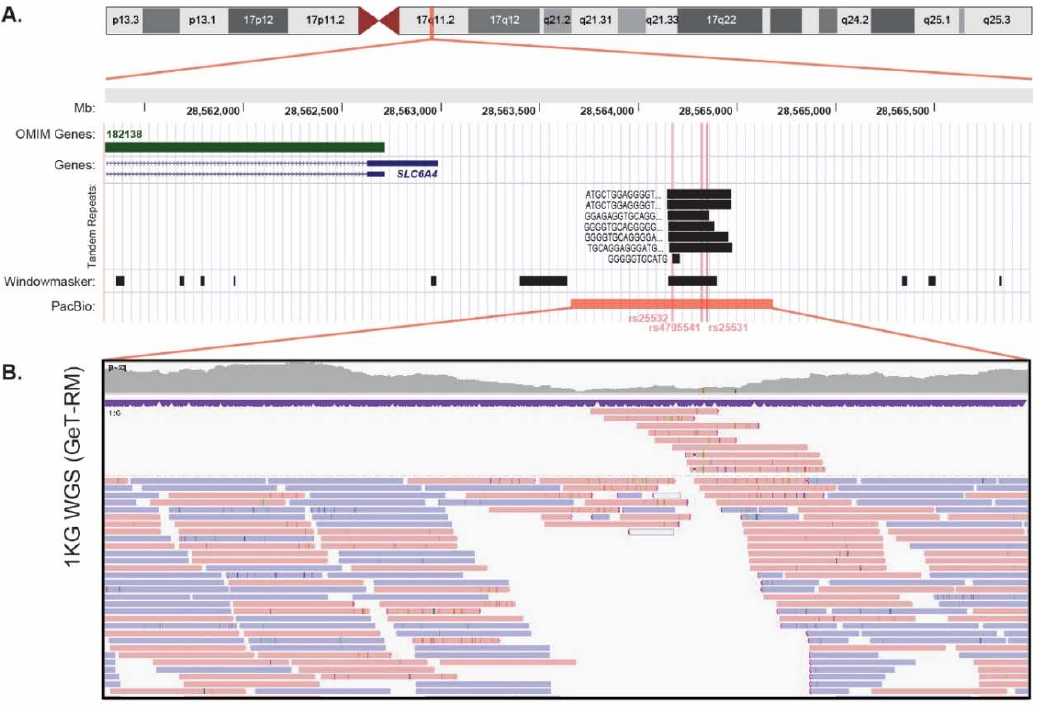
Figure 1. Representative SLC6A4 promoter sequencing of the NA12156 Coriell sample using short ‐ read (Genetic Testing Reference Material Coordination Program (GeT ‐ RM) genome sequencing (WGS), and capture ‐ based sequencing) and long ‐ read single molecule real ‐ time (SMRT) sequencing. Note the inability to interrogate the repetitive SLC6A4 promoter region ( A ) by two short ‐ read sequencing approaches (WGS ( B ) and capture ‐ based sequencing ( C )), in contrast to the 5 ‐ HTTLPR short (S) allele detection and haplotype phasing accomplished by long ‐ read SMRT sequencing ( D ).